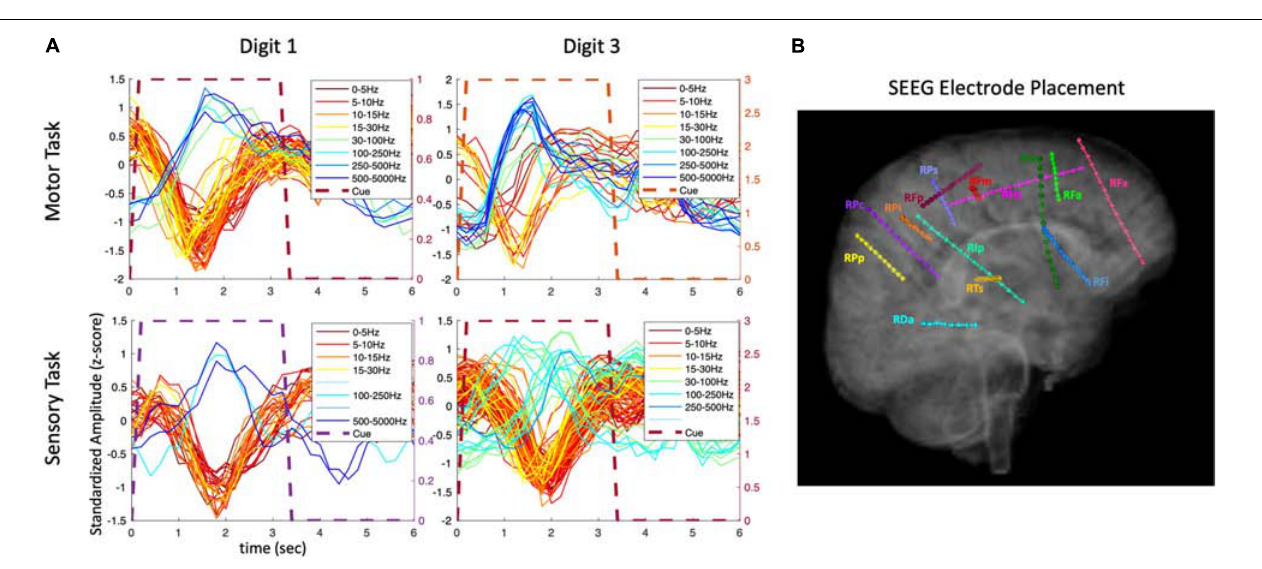
FIGURE 4 | Amplitude modulation and electrode placement in P3_01 (SEEG electrodes). (A) Composite temporal patterns of amplitude modulation in various frequency bands for motor and sensory tasks. (B) Electrode placement in various regions of the